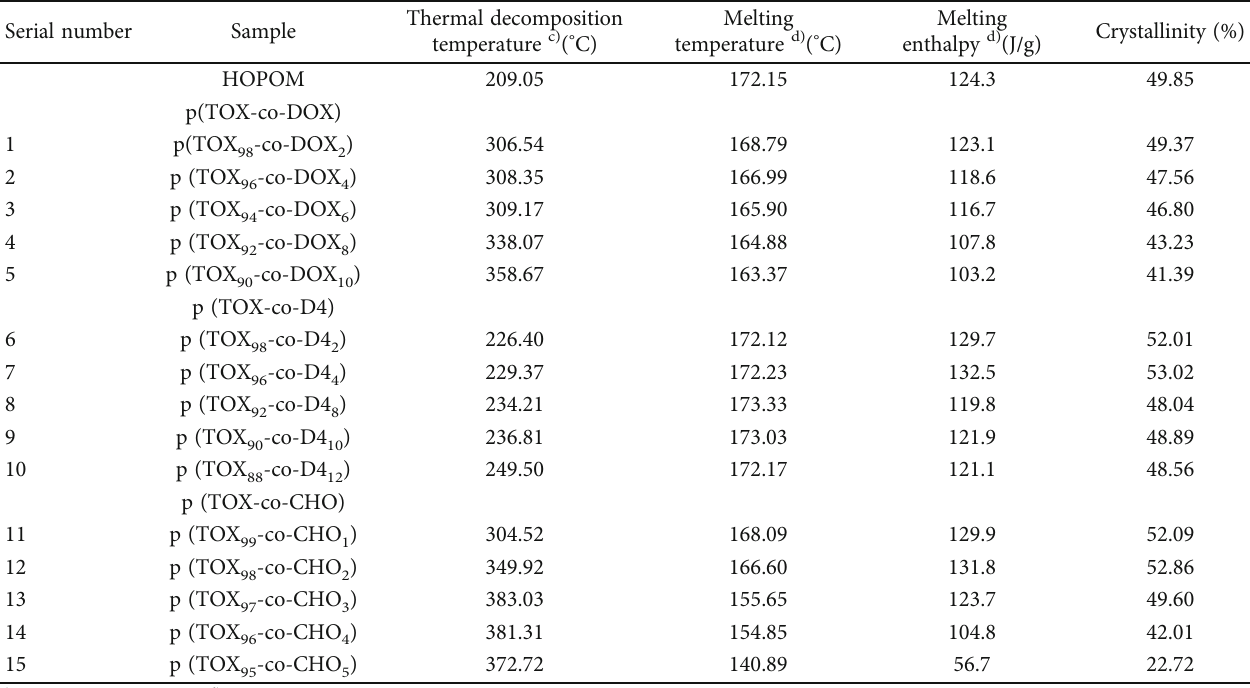
Table 4: TG and DSC results of the